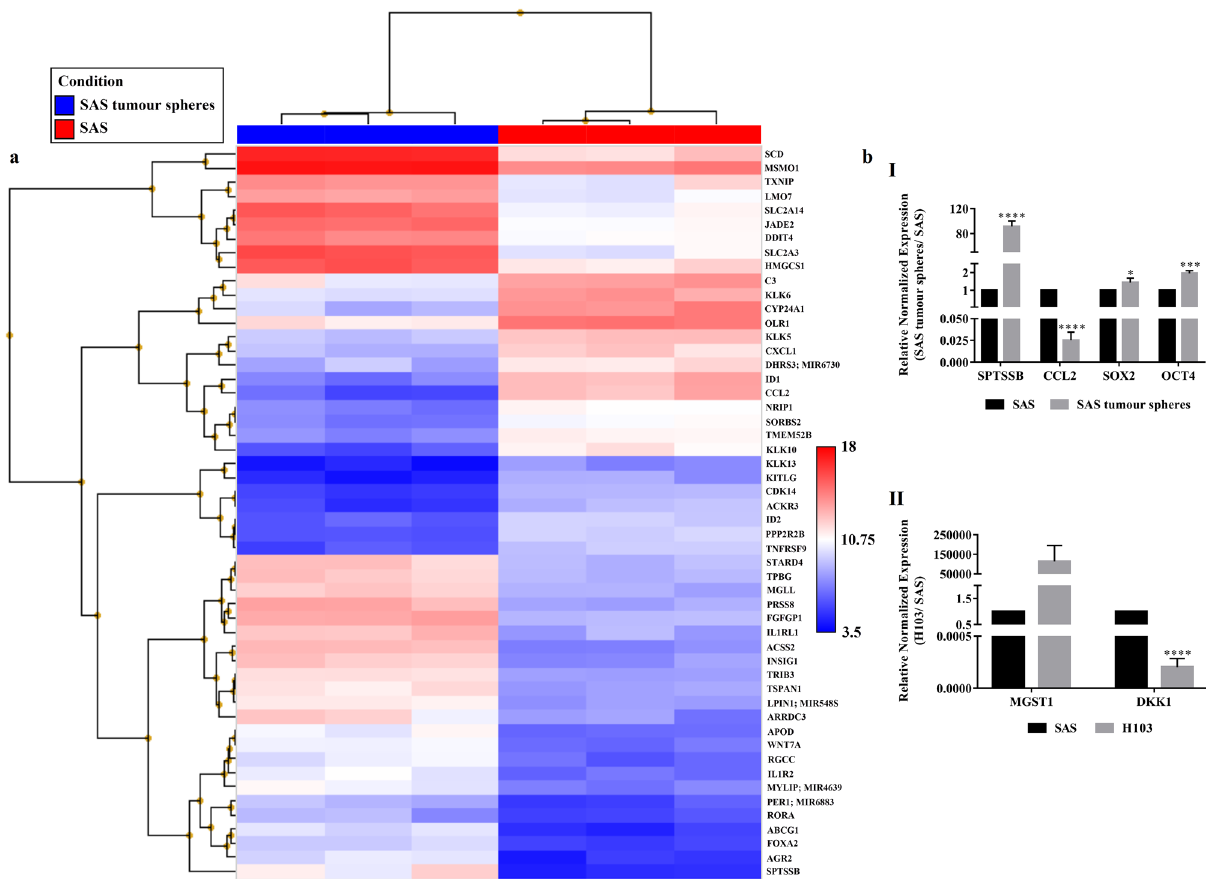
Figure 2. The transcriptomic profiles of SAS cells and their derived tumour spheres as analysed using the Affymetrix Clariom S arrays. ( a ) Heat map generated from the microarray data reflecting log2 normalised gene expression values using the Robust Multi-array Average method, where the p-value adjusted for the false discovery rate was less than 0.05 and the positive or negative fold change exceeded 10. Blue represents lower gene expression and red represents higher gene expression. n = 3. ( b ) Microarray validation through qPCR for the top up- or down-regulated genes in (I) SAS tumour spheres and (II) H103 relative to SAS. Expression of stemness-associated genes, OCT4 and SOX2 , were also measured by qPCR in SAS and SAS tumour spheres. The amplification levels of the genes were normalised against two reference genes, ACTB and GAPDH . Data are presented as mean ± SD. *P < 0.05, ***P < 0.001, ****P < 0.0001, n = 3.